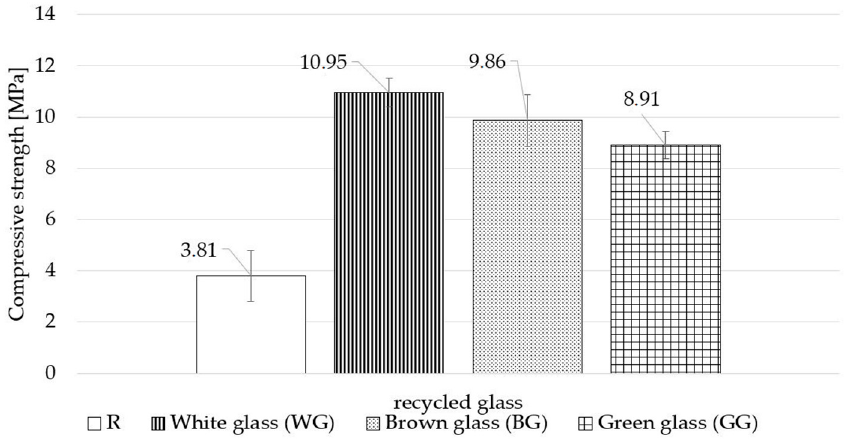
Figure 5. Compressive strength test results.